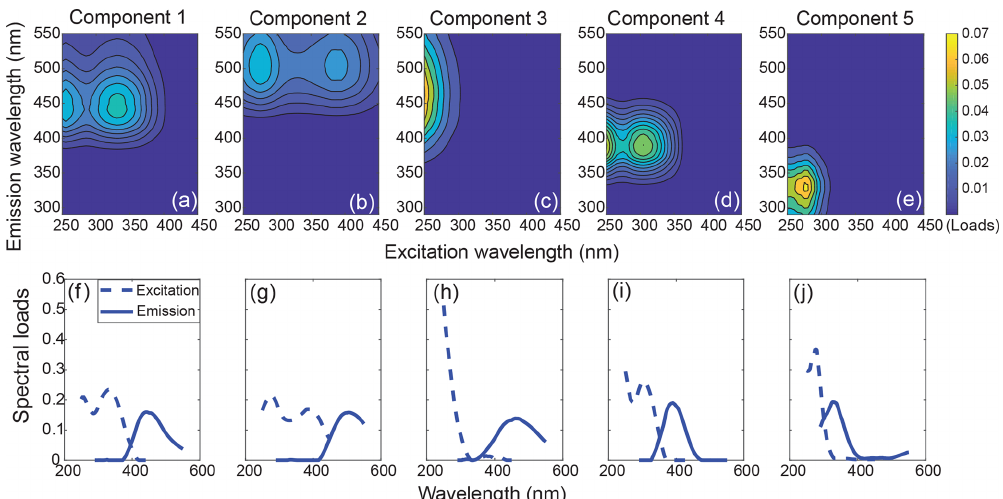
Figure 3. The 3-D fingerprint spectra (a–e) and spectral loads (f–j) of the five components identified by PARAFAC analysis. The overlaid excitation and emission loadings of the validated split dataset can be found in Fig. S4. Table 1. The excitation and emission maxima of our PARAFAC components, and their possible sources and corresponding chemical com- pounds (wavelengths in brackets are secondary maxima). The Tucker congruence coefficients (TCC) are always above 0.95, indicating strong correlations. The respective TCC values can be found in the Supplement (Data Table